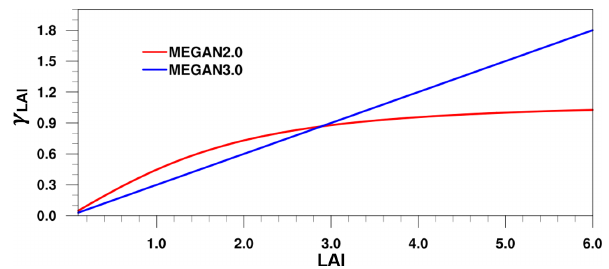
Figure 8. Activity factor for LAI (γ LAI ) variation with LAI in dif- ferent versions of MEGAN. The red line represents the MEGAN v2.0 and the blue line MEGAN v3.0.